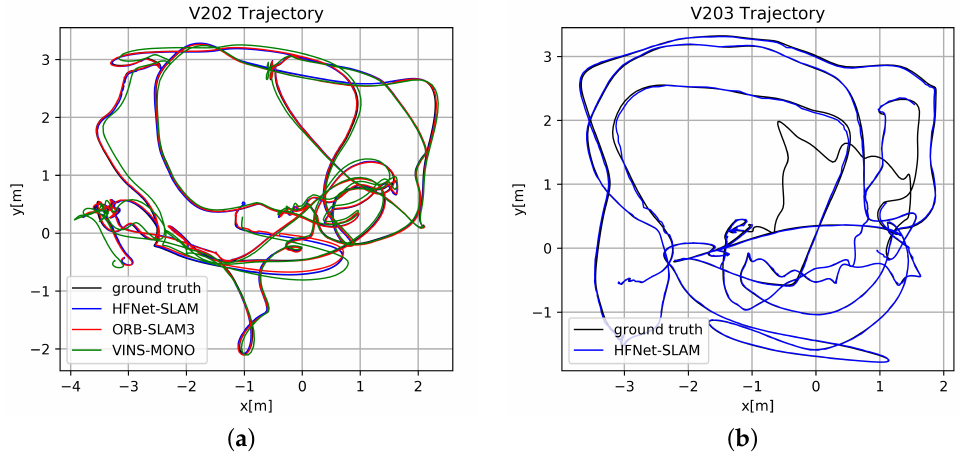
Figure 5. ( a ) Estimated trajectories in V202 sequence with monocular-inertial configuration; ( b ) Esti- mated trajectories in V203 sequence with pure monocular